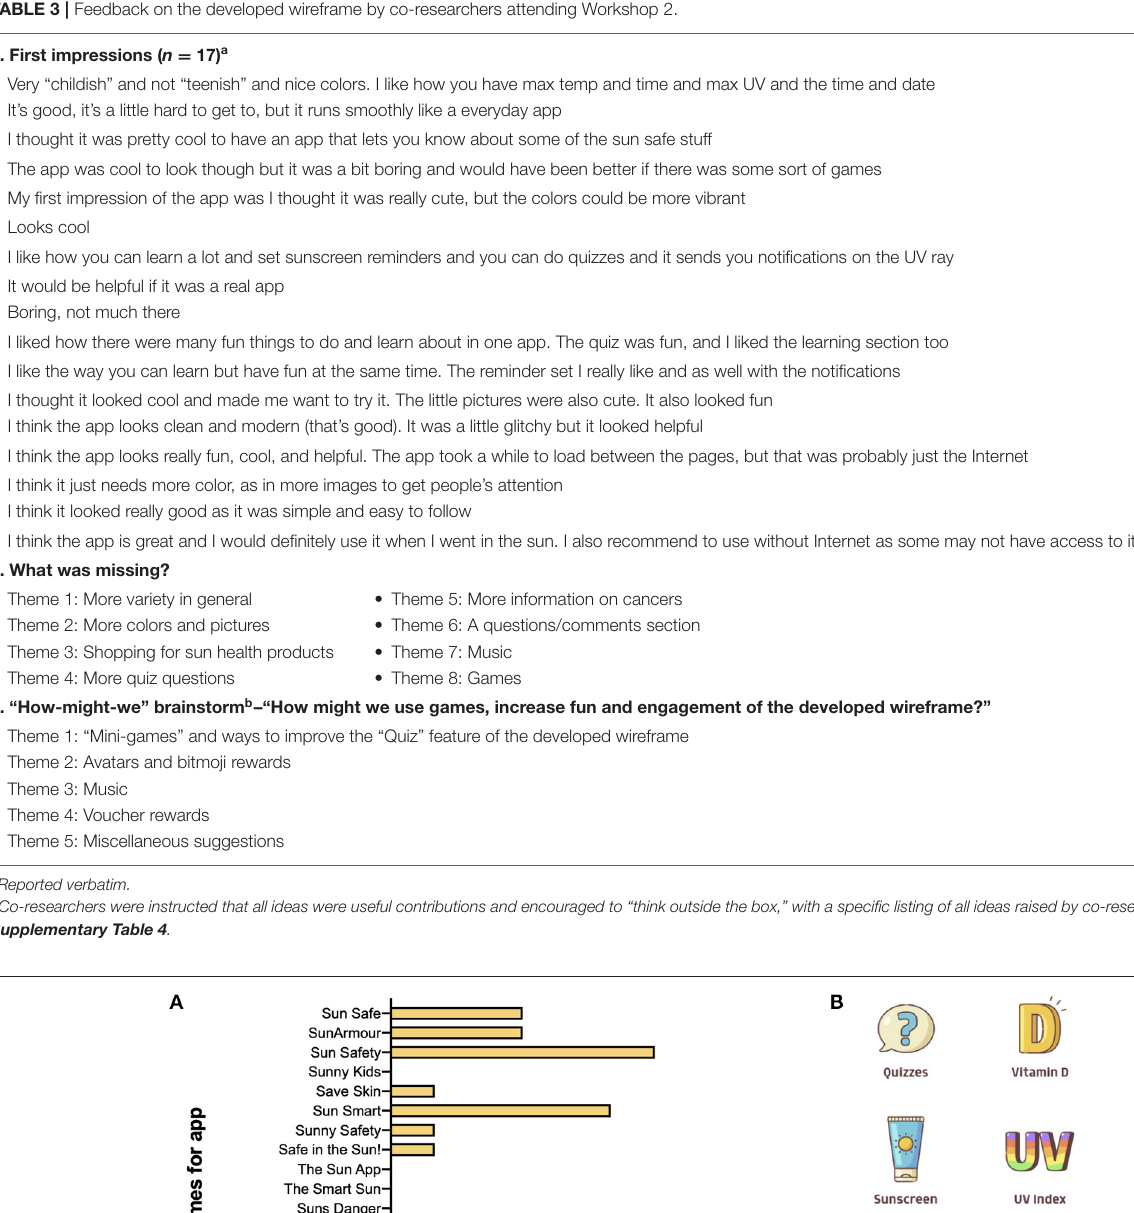
TABLE 3 | Feedback on the developed wireframe by co-researchers attending Workshop 2.